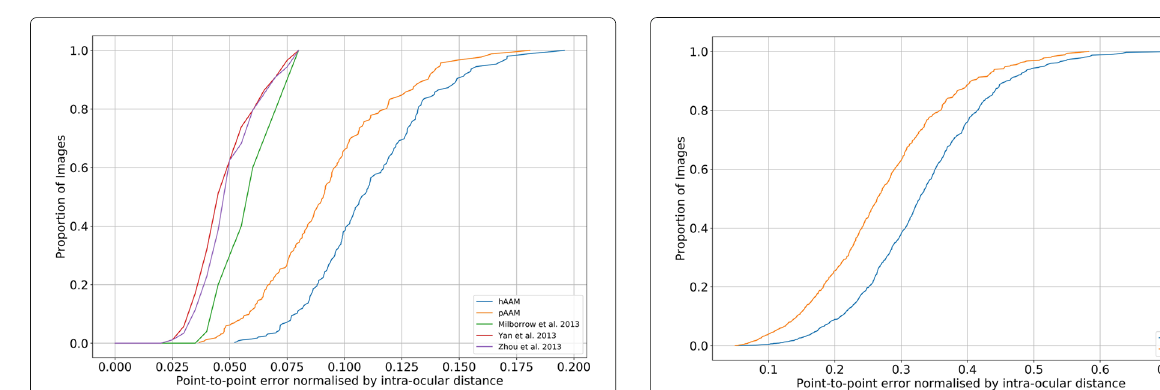
Fig. 16 MUCT cumulative error distributions. Comparing the performance of holistic AAMs and patch AAMs